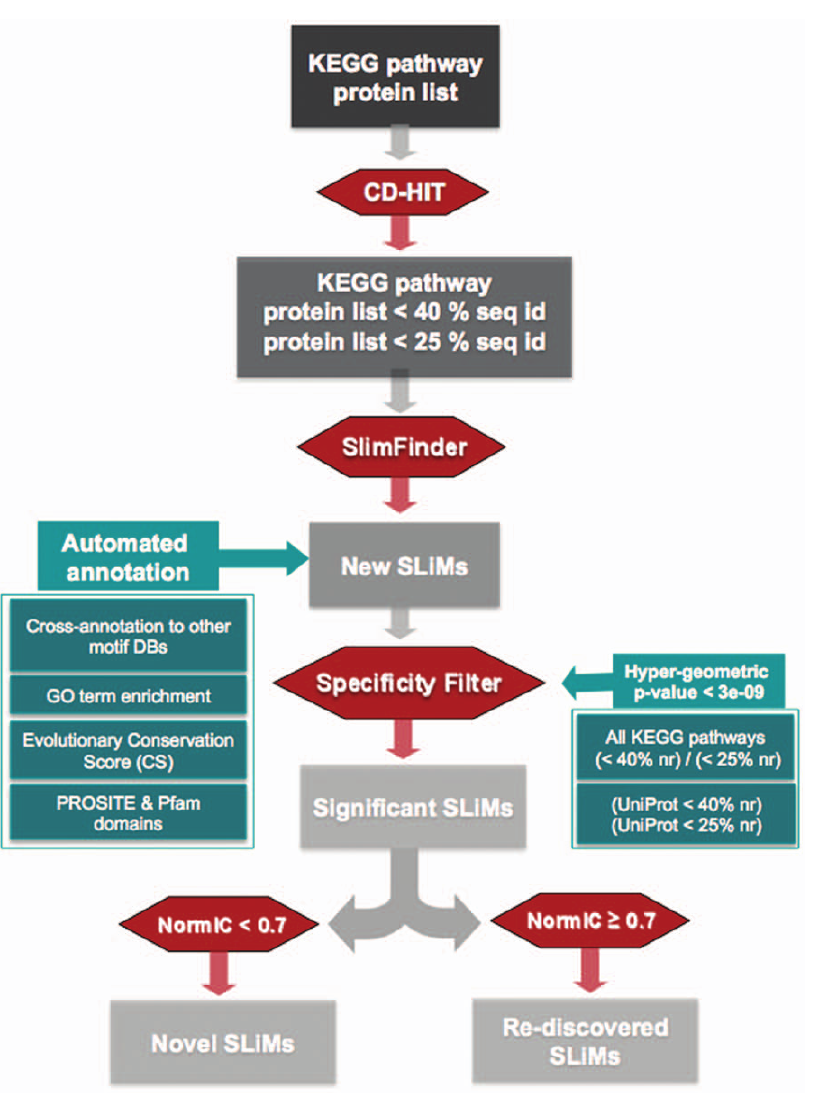
Figure 1. Flowchart of the MoDiPath procedure. NormIC is the CompariMotif [32] similarity score. The CompariMotif tool was used to find similarities between motifs automatically discovered by MoDiPath and motifs already annotated in other databases.